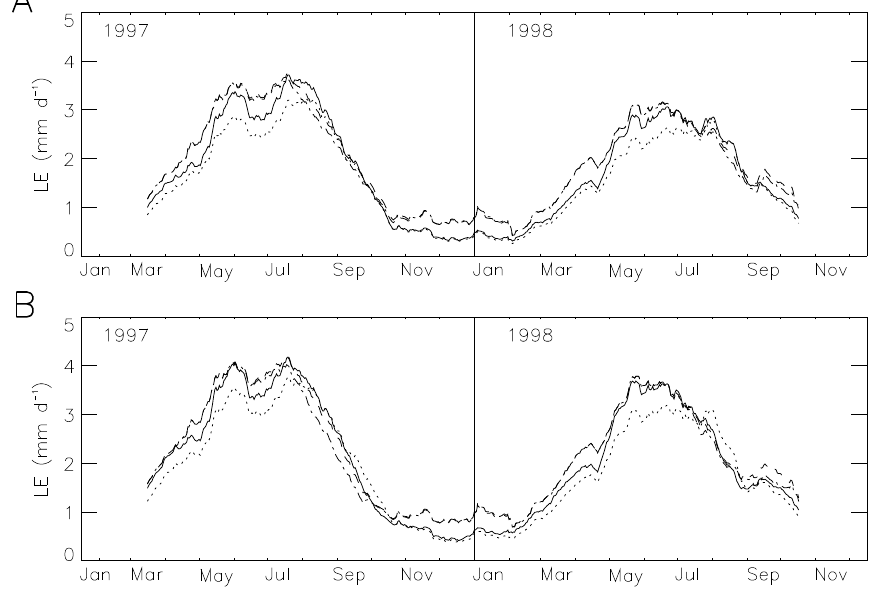
Fig. 7. Modelled ecosystem evapotranspiration ( E) of Le-Bray, for different climate scenarios, 350, 700, 700+ and 700+pp (solid, dotted, dashed, and dash-dotted lines, respectively). Model parameterization used for these runs are identical to those of Fig. 6, considering: (A) a single layer of maritime pine, or (B) a layer of maritime pine and an additional layer representing the purple moor-grass undergrowth. The E values are smoothed using a 30-day moving average, in order to show the general